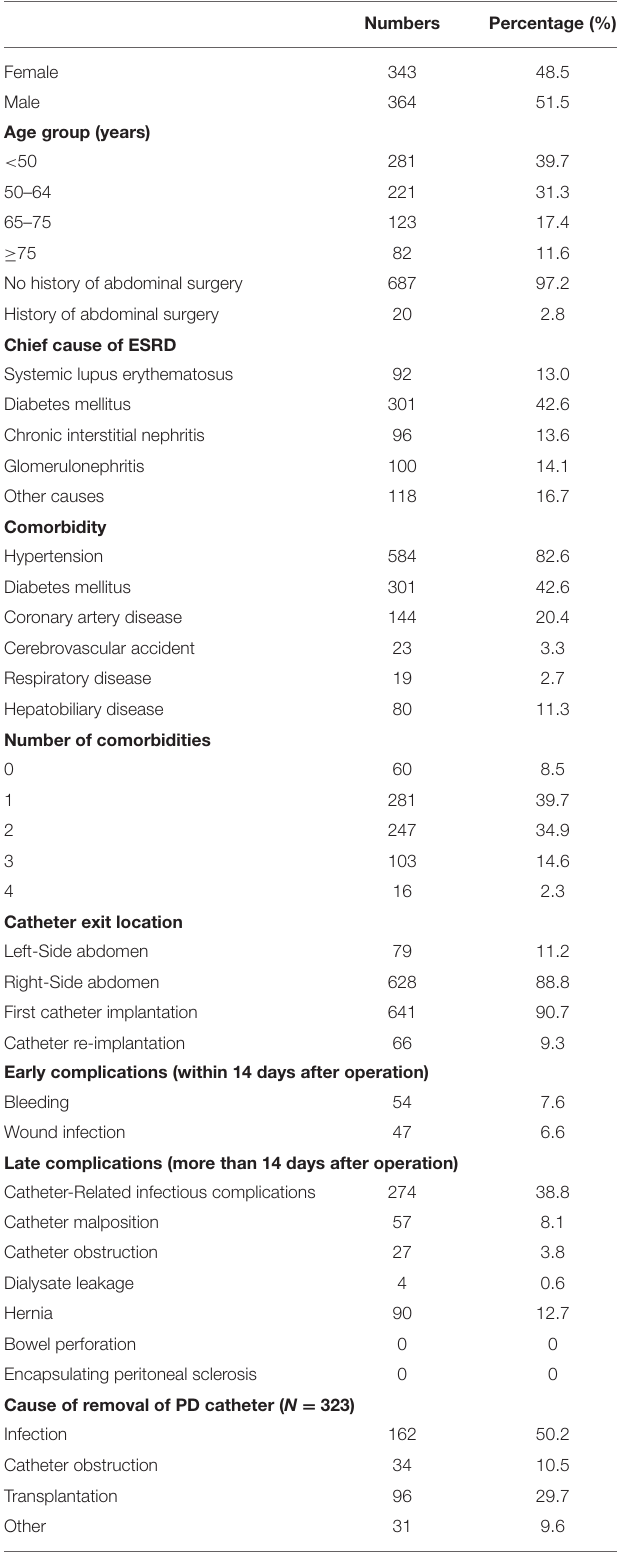
TABLE 1 | Clinical characteristics of the patients ( N =